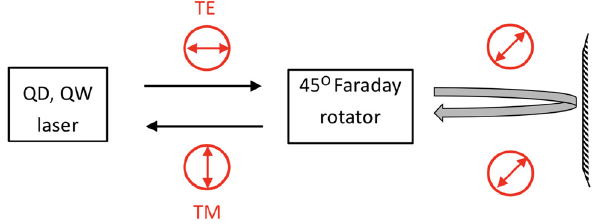
Figure 1: Schematic representation illustrating the principle of the optical isolator with a 45 ° Faraday rotator. Due to the reflection on the mirror, the polarization of the laser light is TE-TM converted. QD: quantum dot; QW: quantum